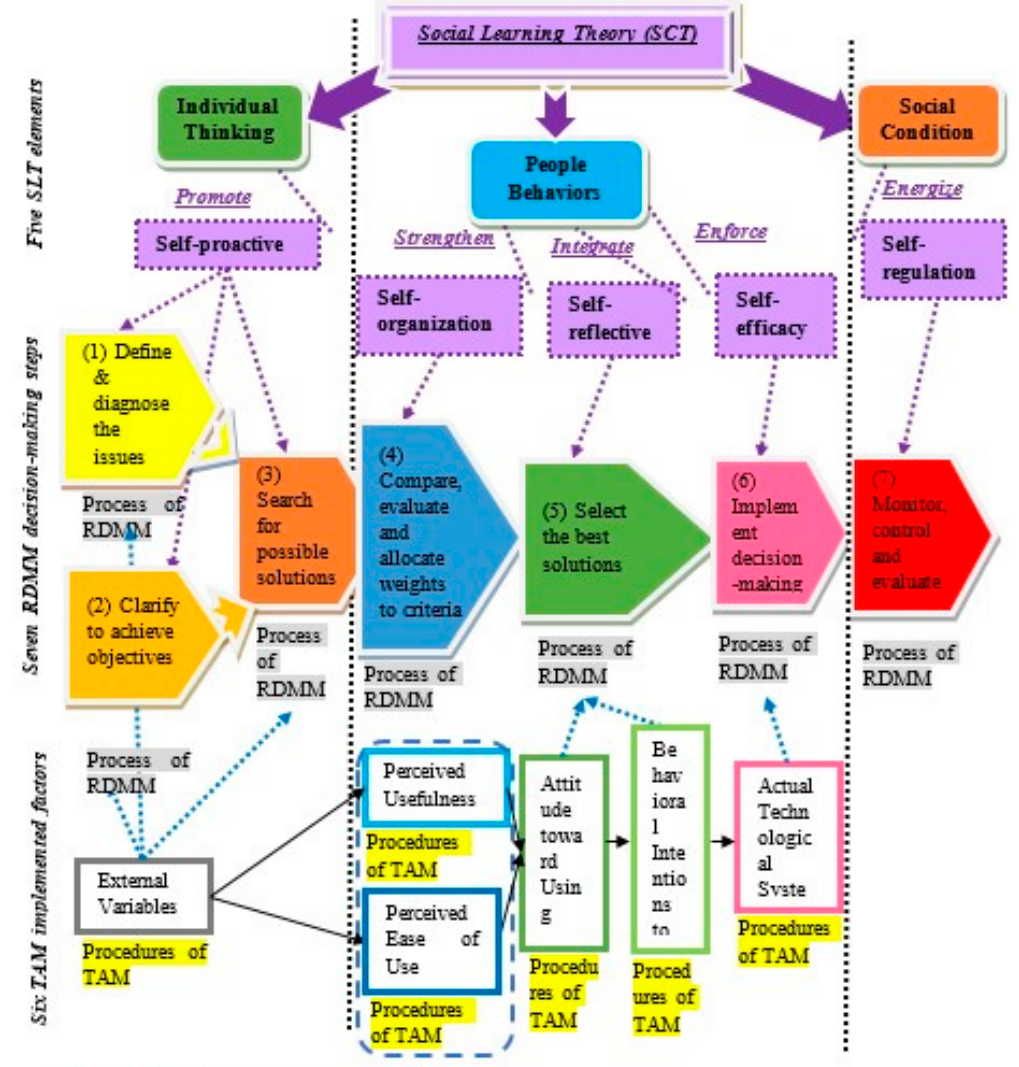
Figure 3. The main evaluated framework.